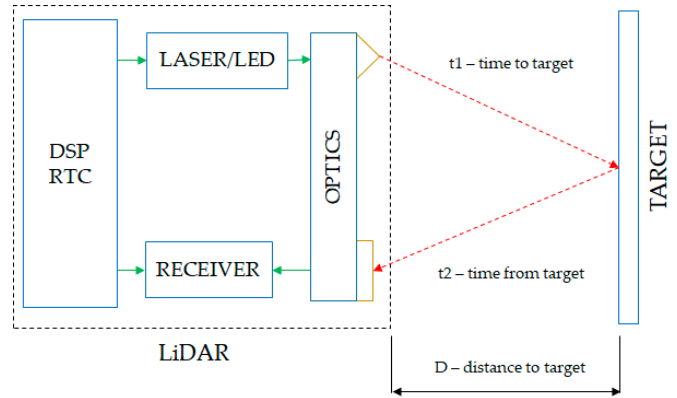
Figure 3. LiDAR measuring distance using time-of-flight [8].